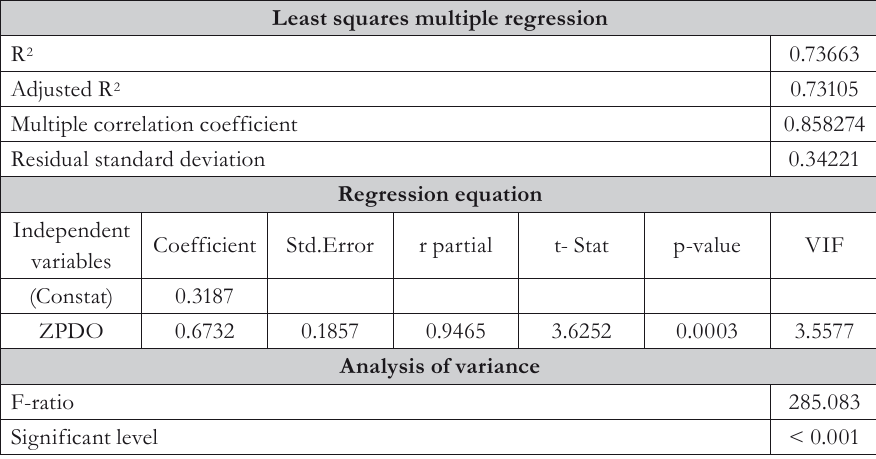
Tab. 7 – Characteristics of the regression model of problems with payment discipline e. Source: own